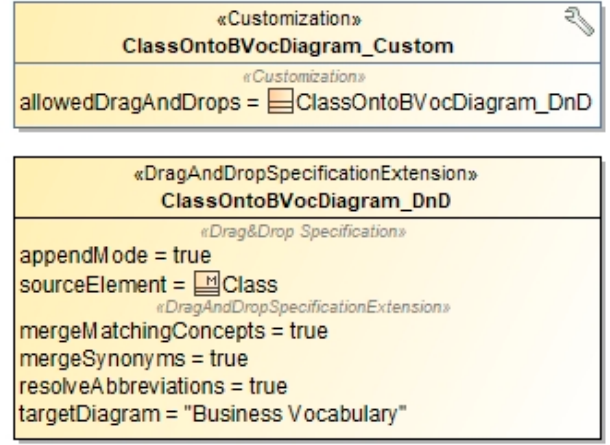
Figure 8. M2M transformation specification for UML Class to semantics of business vocabulary and rules (SBVR) GeneralConcept transformation.